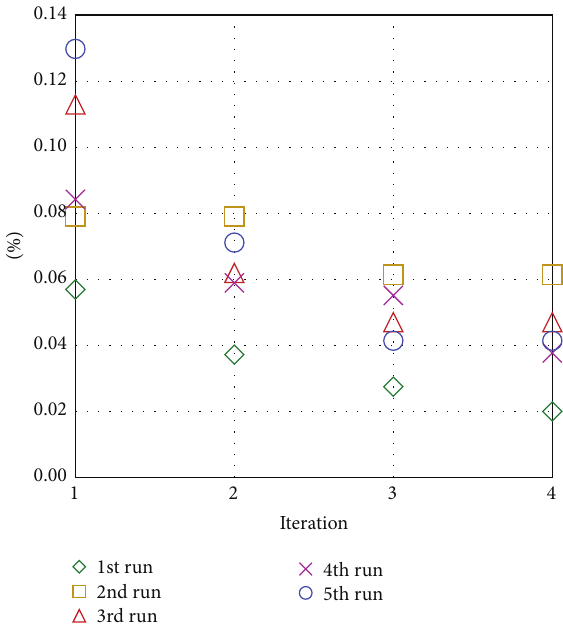
Figure 3: Average-solution-value-deviation-over-iteration plots for five runs of the multi-VNS